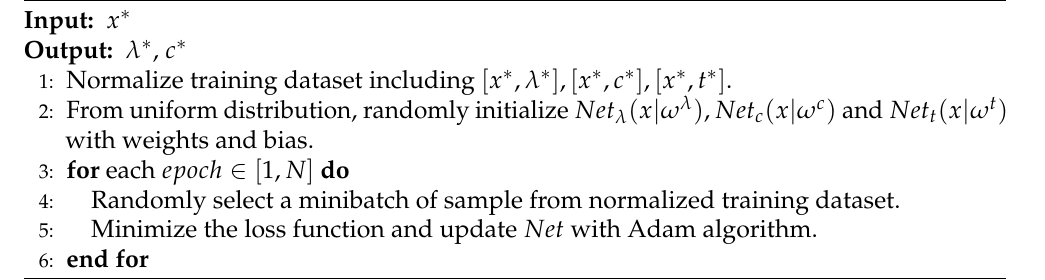
Algorithm 1 Supervised training algorithm of the